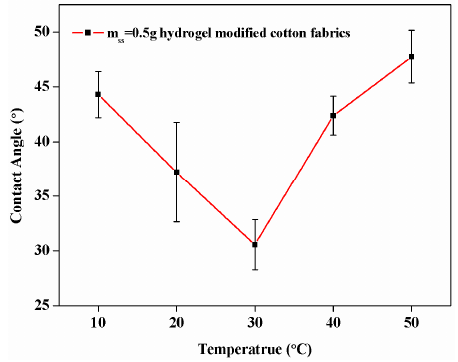
Figure 13. The Contact Angle of IPN hydrogel modified cotton at different temperature.